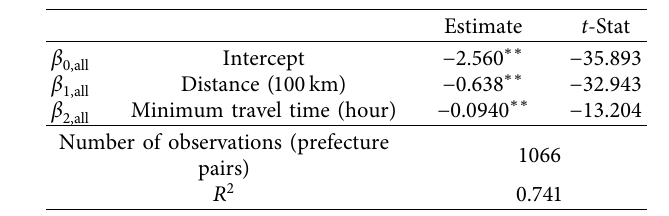
) matrix. all Figure 10: Spatial location of each prefecture by the estimated travel cost. Table 3: Te regression analysis result of travel cost.